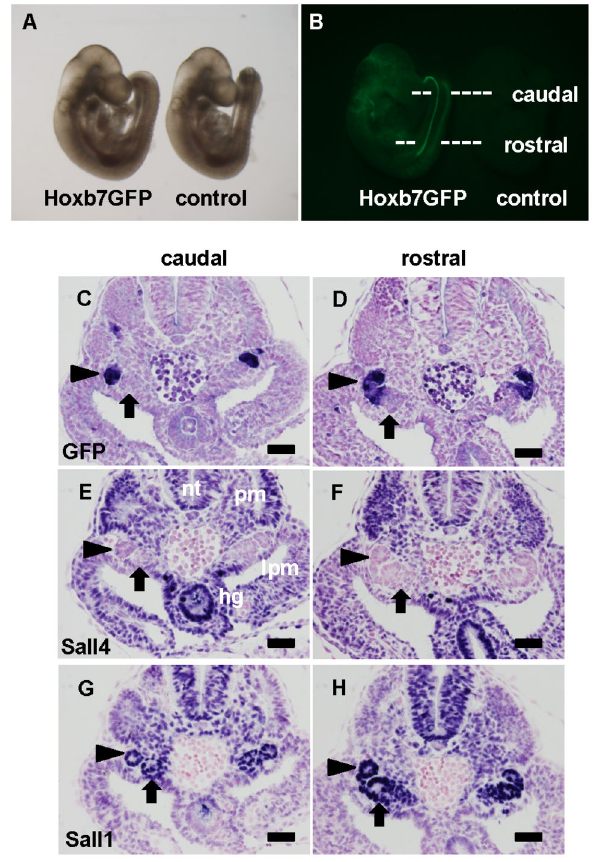
nephrogenic mesenchyme at E9.5. (A, B) Bright-field and fluorescence views of Hoxb7GFP and control mice at E9.5. The dotted lines indicate the planes used for the caudal and rostral sections in the following panels. (C, D) Green fluorescent protein staining of caudal and rostral sections from a Hoxb7GFP mouse. (E, F) Sall4 staining of the neighboring sections. (G, H) Sall1 staining of the neighboring sections. Arrowhead: Wolffian duct; arrow: nephrogenic mesenchyme;